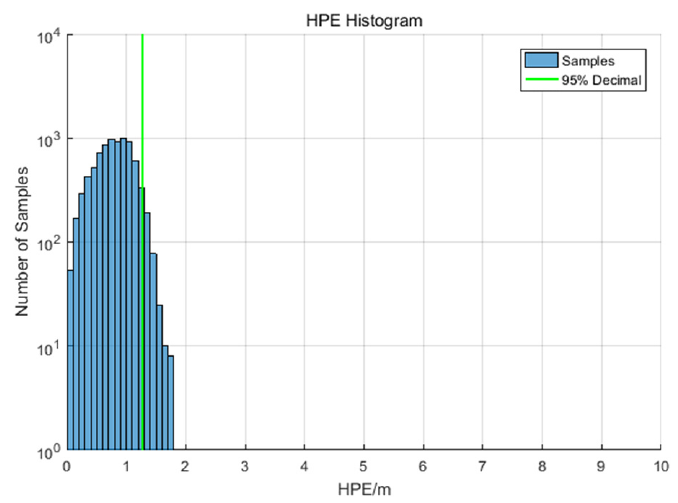
Figure 15. The HPE histogram of flight test-II. The green line in the figure is the horizontal accuracy (95%), which is 1.27 m.